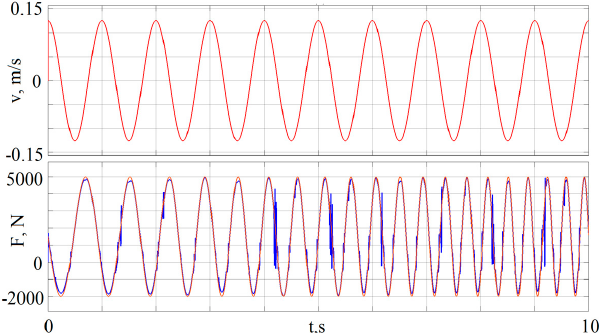
Figure 11. Desired force as a sine wave with increasing frequency. Top: velocity of the rod; bottom: force on the rod (red—desired, blue—actual).